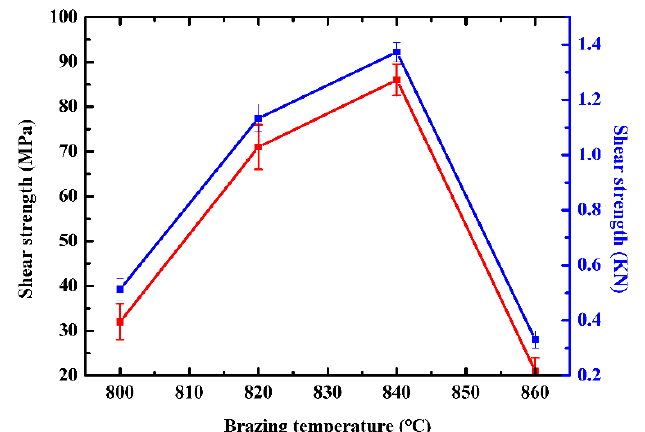
Figure 7. Schematic diagram of microstructural evolution of TiZrHfNbMo HEAs/Si 3 N 4 brazed joint. ( a ) Schematic diagram of brazing interfacial, ( b ) Interface between zone I and zone III, ( c ) Interface between zone I and zone II, ( d ) Brazing assembly diagram, ( e – g ) Atom diffusion and phase generate during brazing. Figure 8. Effect of brazing temperature on the shear strength of TiZrHfNbMo HEAs/Si 3 N 4 joints brazed.